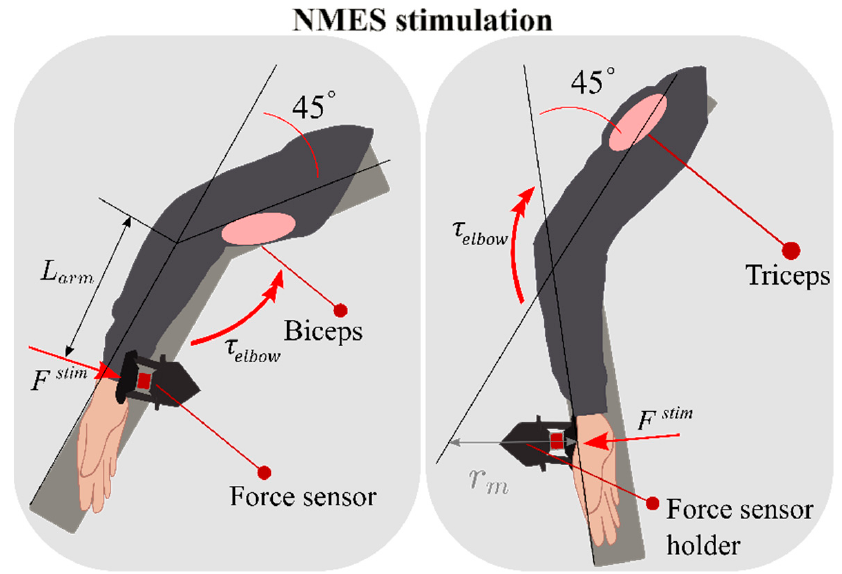
Figure 2. Calibration setup: top-view of the single-degree-of-freedom elbow platform to calibrate the NMES system. The whole arm was lying on the support; the wrist was positioned in concomitance with the force sensor holder, against which the subject applied the force generated after the NMES stimulation. On the left panel, the NMES stimulation targeted the biceps muscle (pink-colored oval), the resultant force generated ( F stim ), and the torque acting on the elbow ( 𝜏⃗ (cid:3032)(cid:3039)(cid:3029)(cid:3042)(cid:3050) ). On the right panel, an equal representation of when the NMES stimulation targeted the triceps muscle (pink-colored oval).